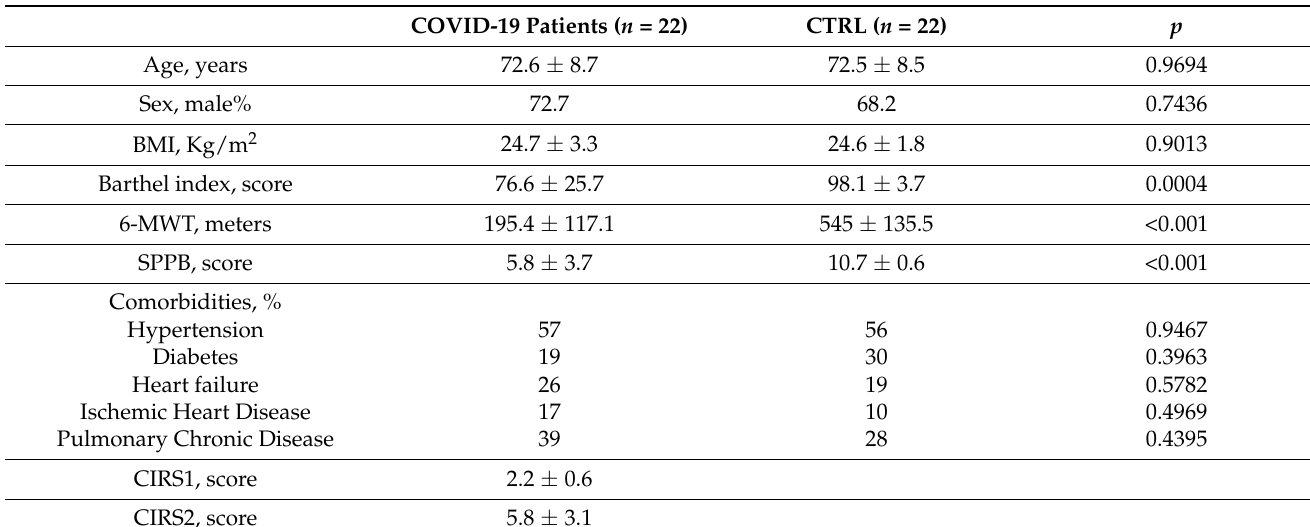
Table 1. Clinical characteristics of COVID-19 patients and controls